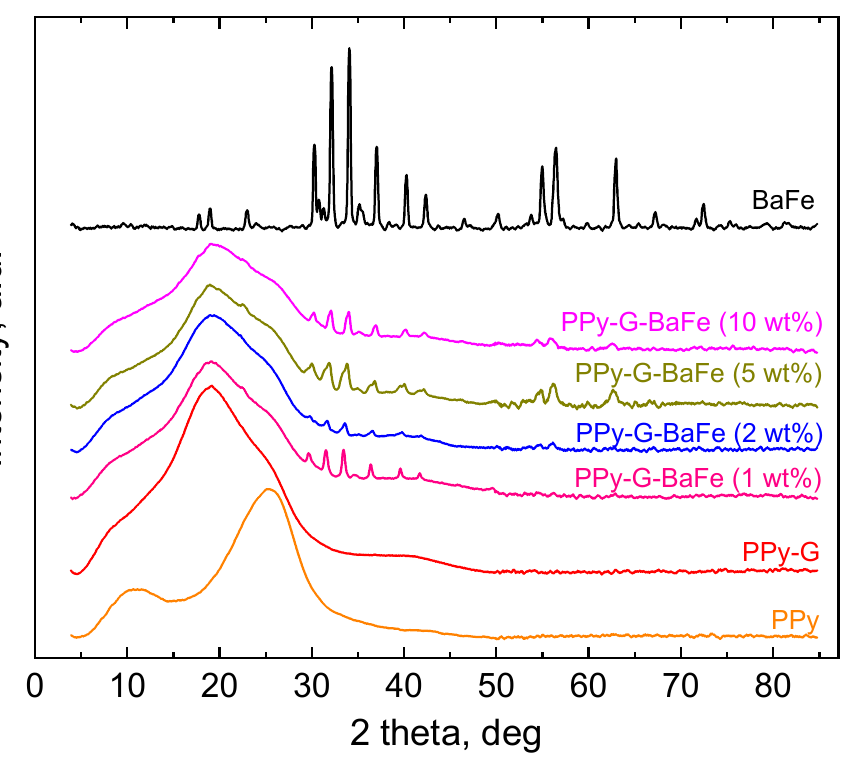
Figure 3. XRD patterns of PPy-G-BaFe aerogels prepared using various fractions of BaFe, PPy-G aerogel, pristine PPy and pristine BaFe.